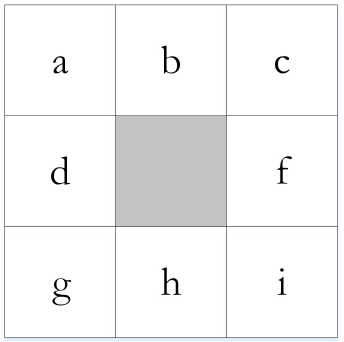
Figure 2. The square neighborhood of three by three